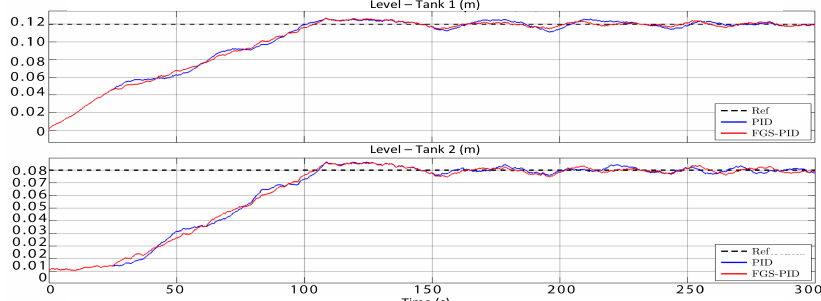
Figure 8. Simulation results of the control systems.